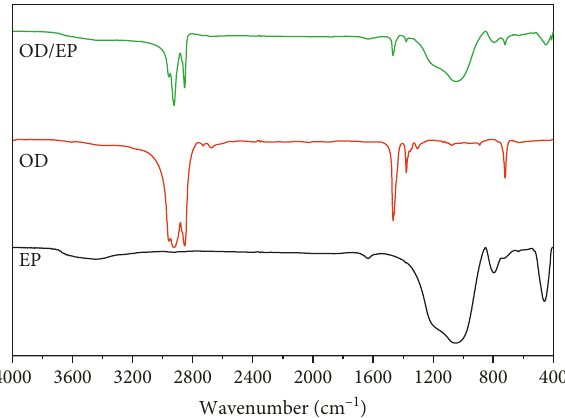
Figure 3: FT-IR spectra of EP, OD, and